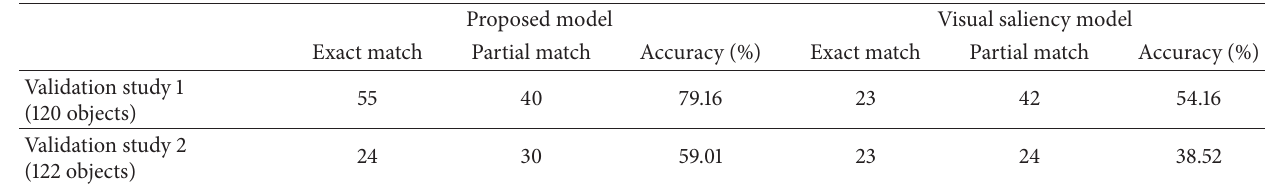
Table 6: Results of the validation studies.